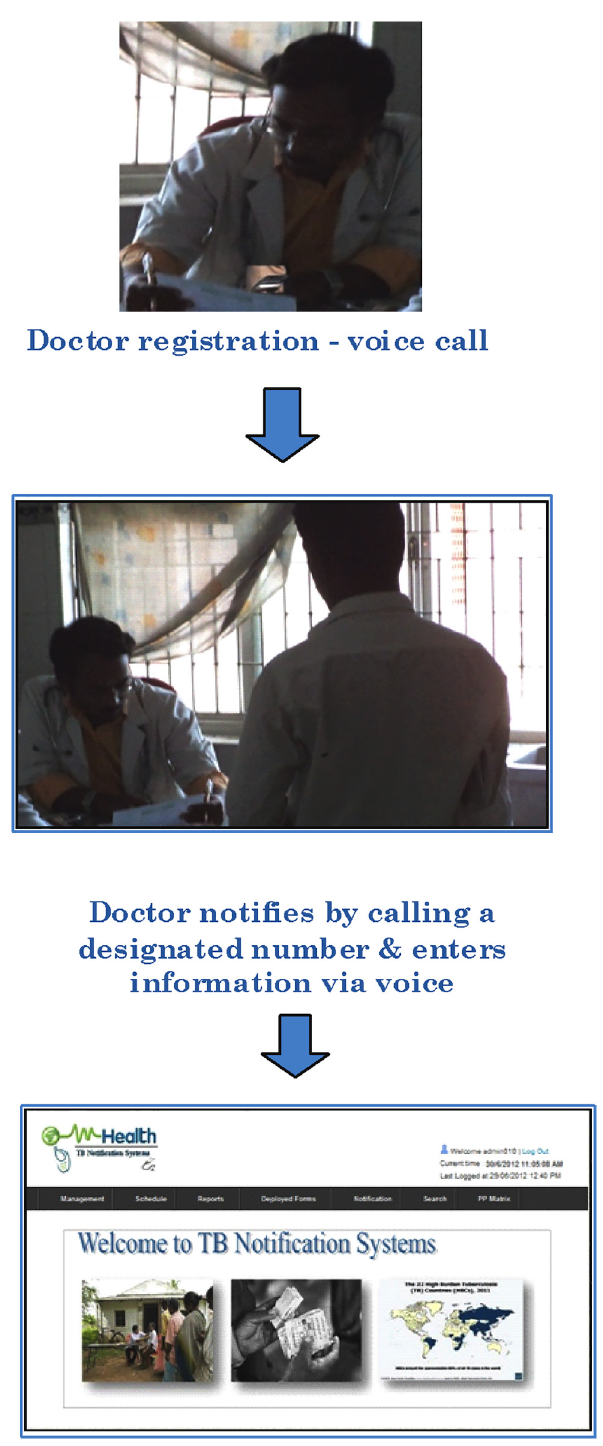
Fig 1. Steps involved in TB case notification by private medical practitioners using MITUN.